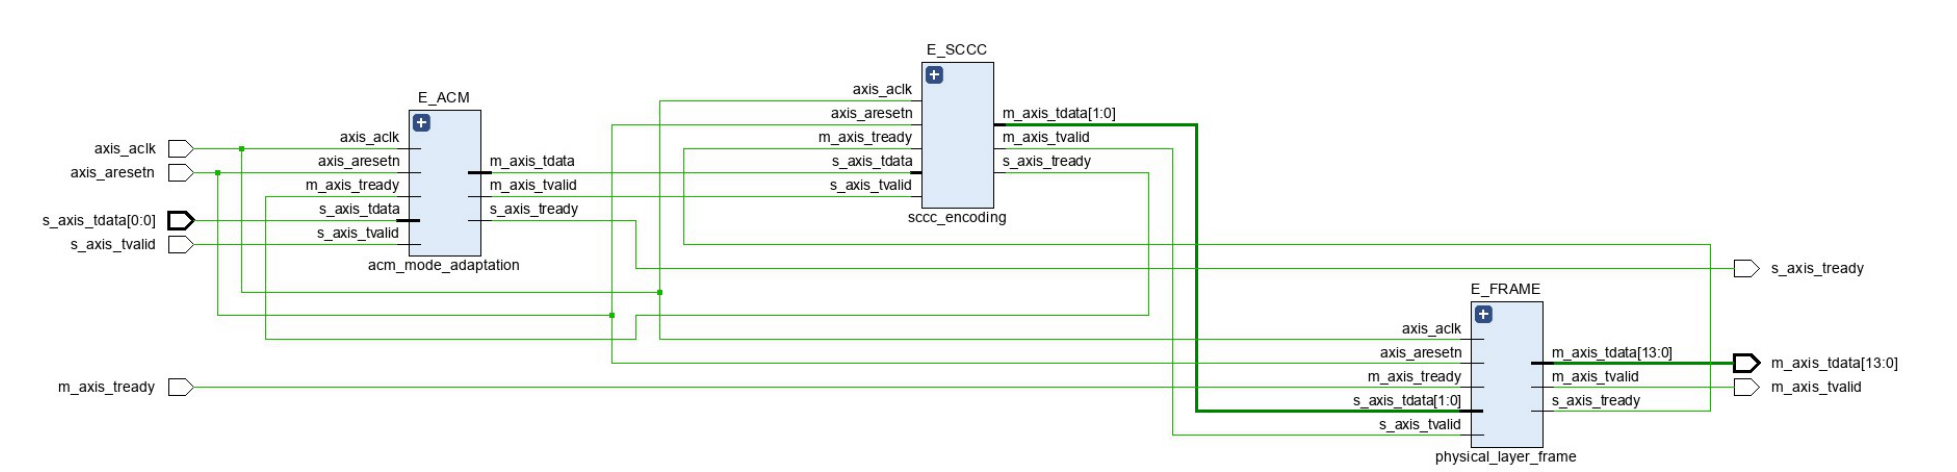
Figure 14. Transmitter RTL block